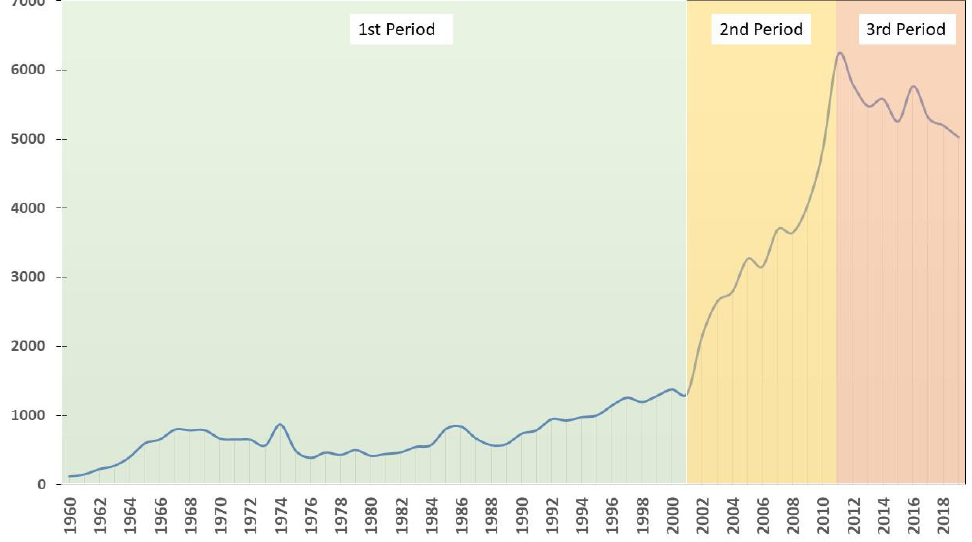
Figure 2. Worldwide temporal evolution of medical plants publications.